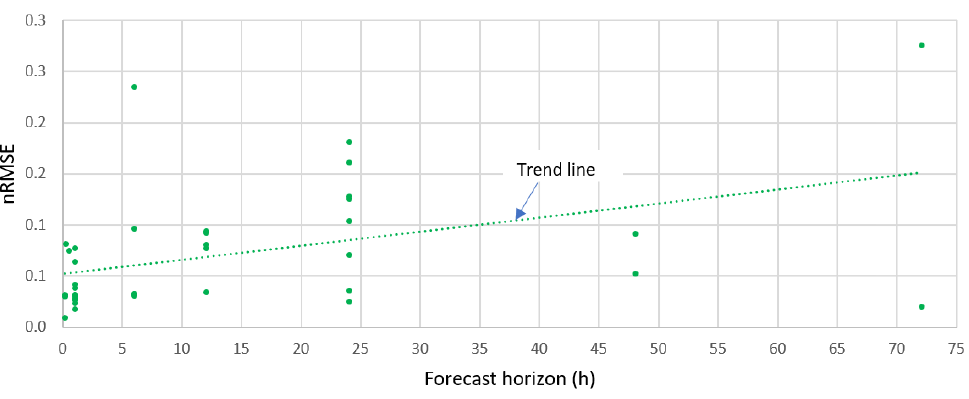
Figure 11. Magnitudes of error by forecasting horizon.